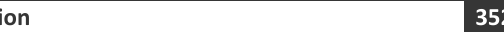
Correction Corrigendum: The structural validity and measurement invariance across gender of the Brief Corporate Entrepreneurship Assessment